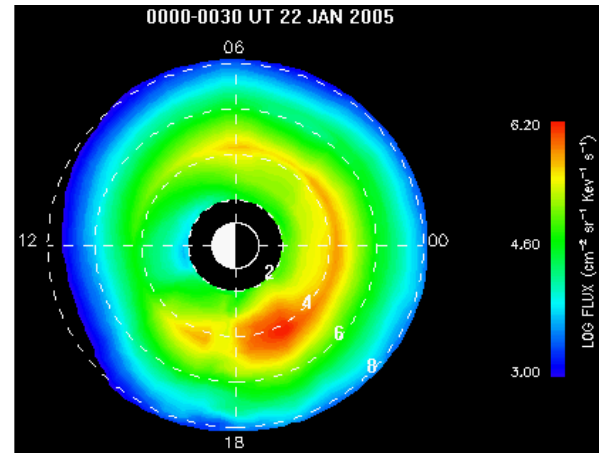
Fig. 7. The optimal equatorial ion distribution contour with pitch angle 90 ◦ , where the closed dashed curves represent the L-scale (2– 8) in Earth radii. Local times and a color scales are provided outside the perimeter of the outermost L-boundary.